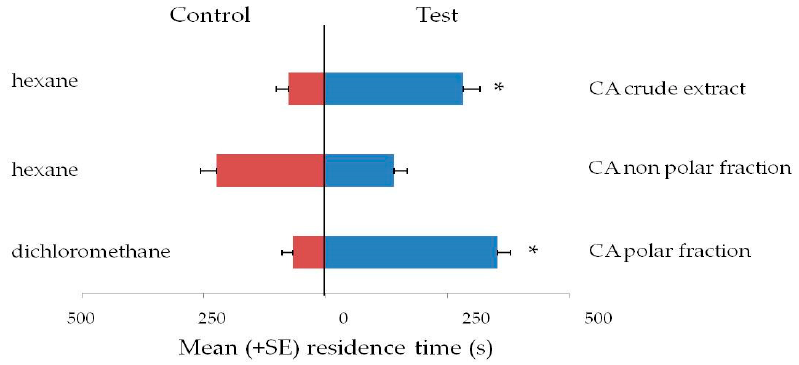
Figure 2. Olfactory response of Lasioderma serricorne adults to C. annuum (CA) extracts and fractions thereof in a Y-tube olfactometer. Bars indicate the mean residence time (+ SE) adult beetles spent in the arm with the odor source. Thirty insects tested per treatment, T -test for dependent samples, * p < 0.01.